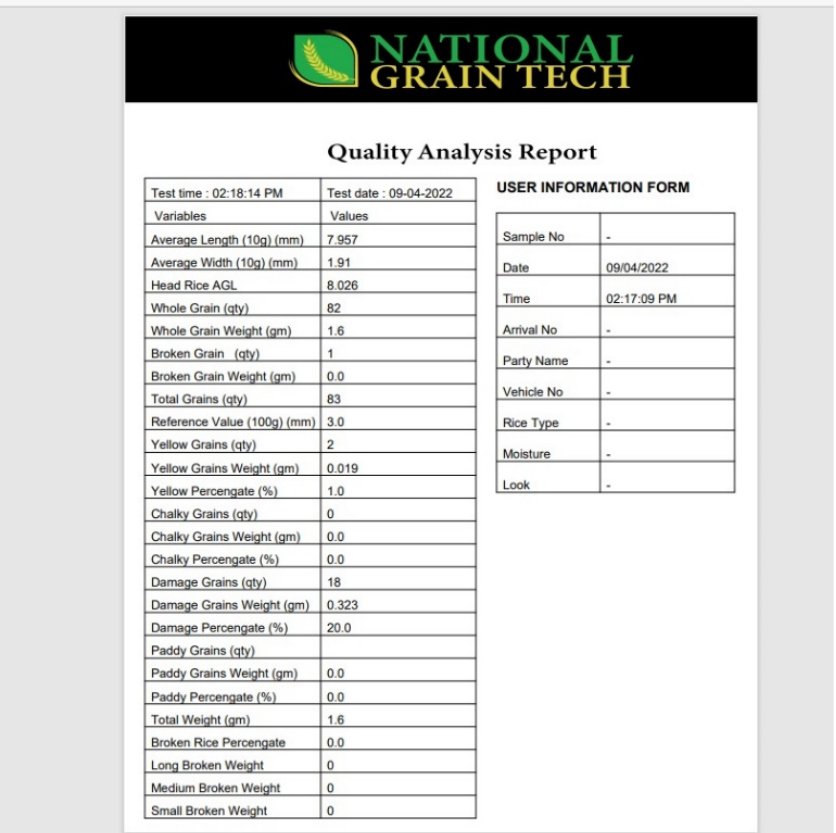
Figure 16 . National Grain Tech-generated report. Figure 16. National Grain Tech-generated report.